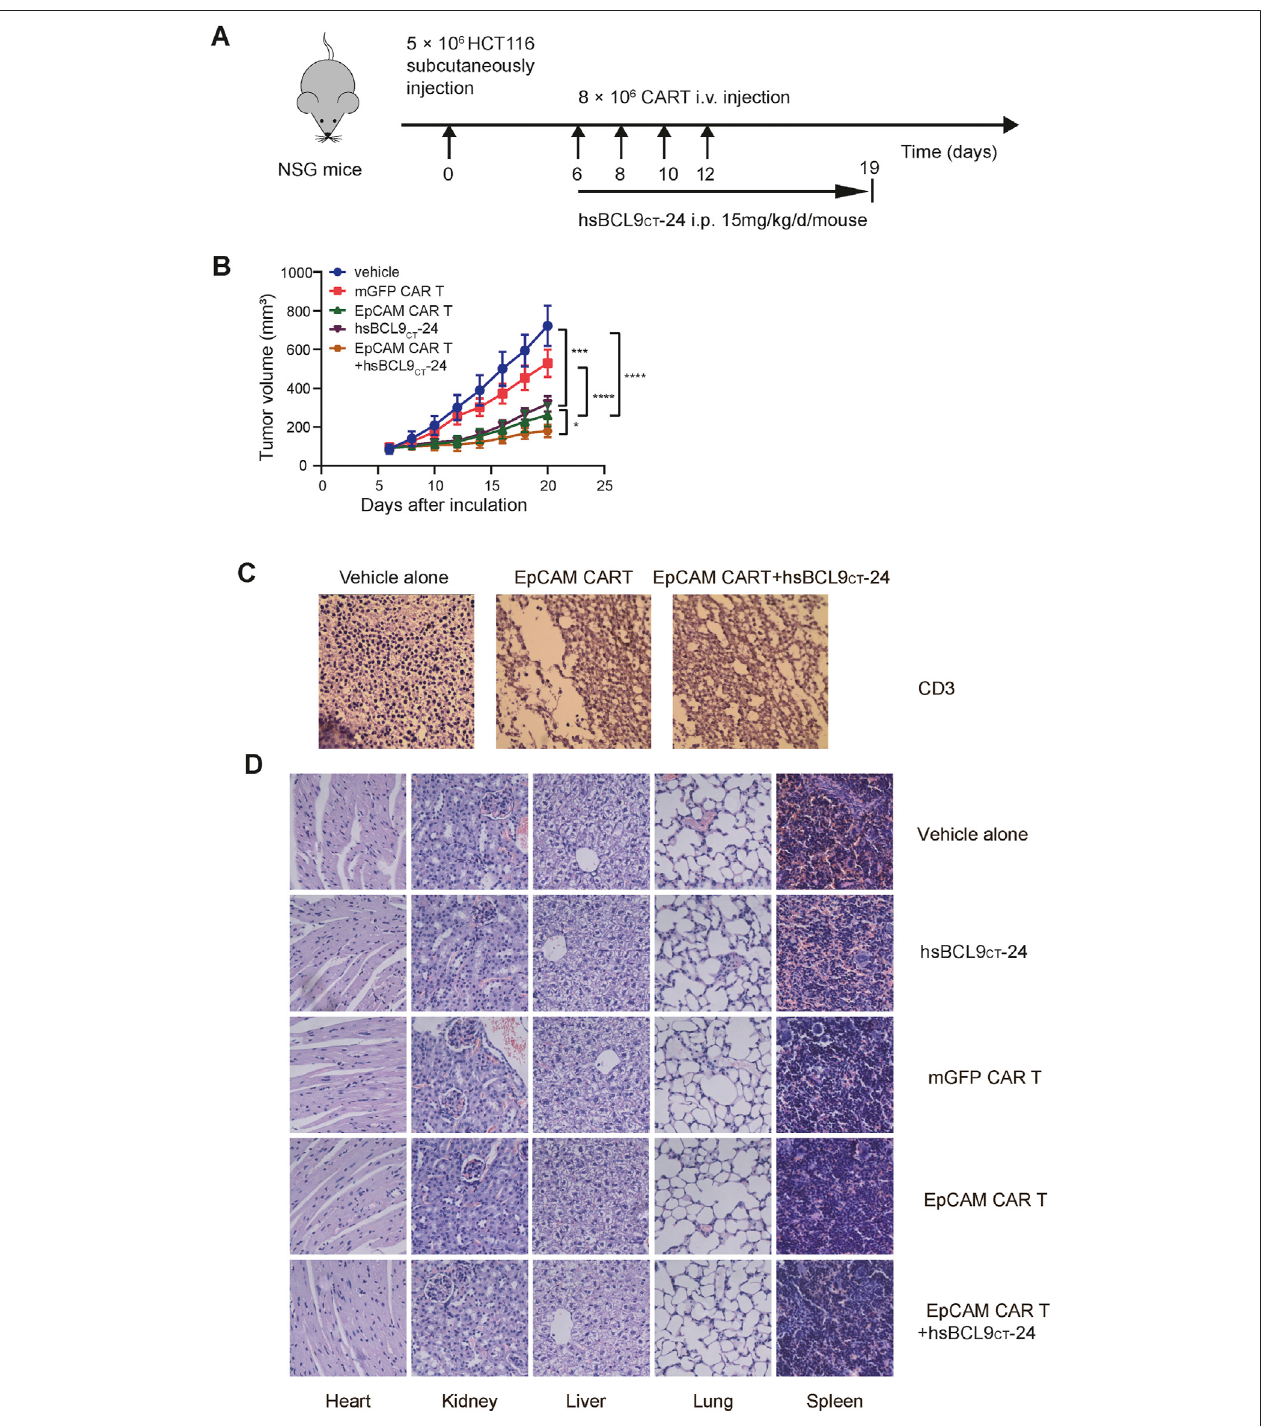
FIGURE6| SynergeticactivityofhsBCL9 CT -24withEpCAMCARTinHCT116mousemodelandsafetyevaluationofCAR-TcellsorhsBCL9-CT24intheHCT116 tumor model. NSG micewere subcutaneously injected with 5 × 10 6 HCT116 on day 0 then randomized on day 6 and treated asfollowing: vehiclealone(2.5% DMSO in 5% Glucose), mGFP CAR Tcells (8 × 106cells, by i.v., every other day for 4 times), EpCAMCAR T cells(8 × 106cells, byi.v., every other day for4 times), hsBCL9 CT -24 peptide(15 mg/kg,byi.p.,withdailydosefor14 days),andEpCAMCARTcellssynergizedwithhsBCL9 CT -24peptide. (A) Schematicdiagramshowingtheinvivo experiment. (B) The tumor growth curves during the experiment. (C) The in fi ltration of T cells into tumor by IHC staining for CD3 ε . (D) H&E staining of main visceral tissues,including theheart, liver, kidney,lungand spleenfrom treatmentmouse (400 × ). Results areshown asmeans ± SEMforexperiments performedin triplicate, and the statistical signi fi cance of differences between groups was determined by the unpaired Student ’ s t test. * p < 0.05; ** p < 0.01, *** p < 0.001.